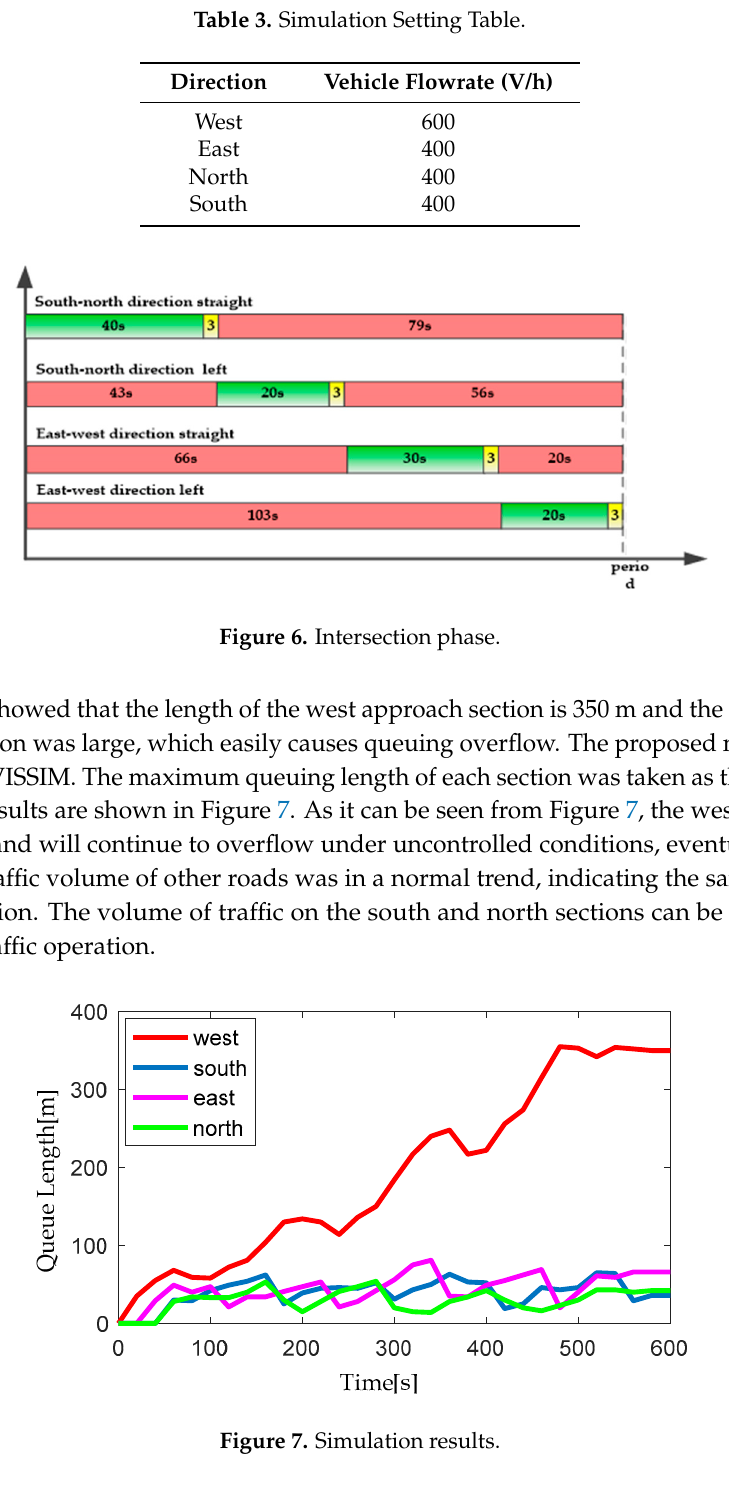
Figure 7. Simulation results.